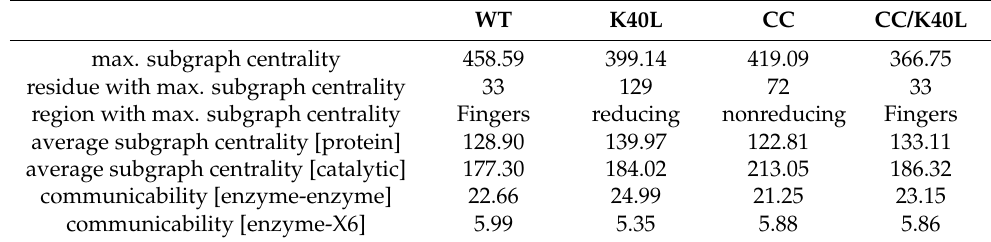
Figure 4. Final structures of the xyn11A mutants-xylohexaose (X6) complexes of ( a ) Wildtype (WT), ( b ) K40L, ( c ) S100C/N147C or CC, and ( d ) S100C/N147C/K40L (CC/K40L) after 100 ns MD simulations. Sidechains of X6 binding residues were shown in orange. Regions with increased communicability relative to the wildtype were highlighted in blue, while regions with decreased communicability were shown in red. Mutated residues were highlighted in green and the residues with maximum subgraph centrality were highlighted in dark blue. ( Right ) the region-wise matrix of communicability changes relative to the wildtype complex was also provided for each mutant. Table 1. Parameters calculated from communicability matrices of four